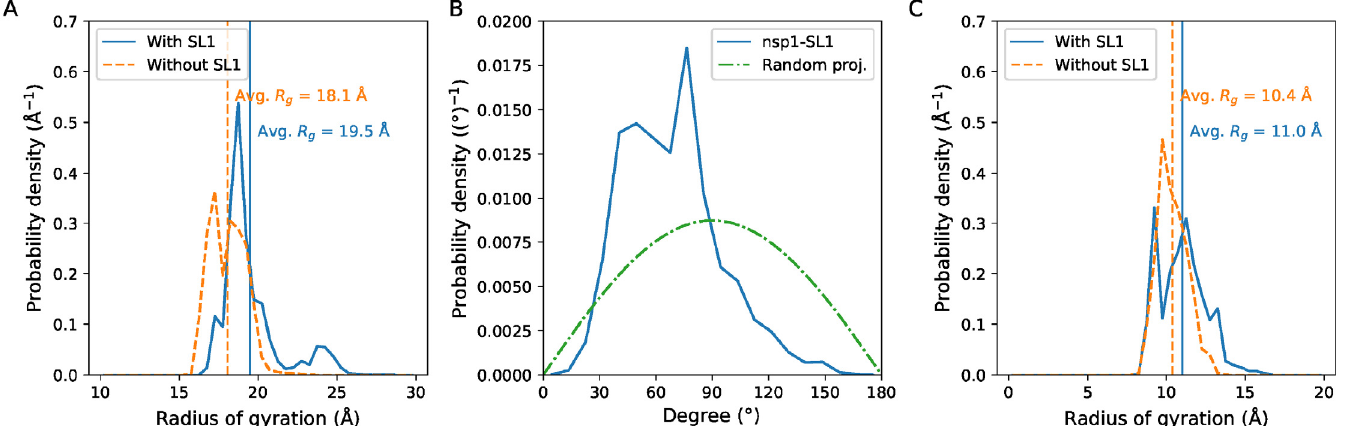
Fig 7. Nsp1 IDR and SL1 are partially aligned. (A) The radius of the gyration of nsp1 C α atoms with or without SL1. Vertical lines represent the average. (B) The distribution of angle between SL1 and nsp1 residues 121–146 (see Materials and methods for the definition). The theoretical angle distribution of two random vectors are also presented for comparison. (C) The radius of the gyration of nsp1 C-terminal IDR. For (A)-(C), the ordinate represent the probability density, i.e. the ordinate are scaled so that the area under the curve is exactly 1.